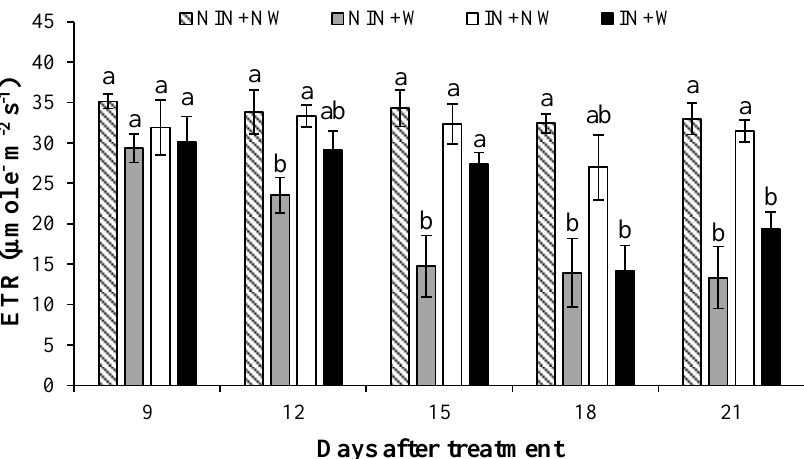
Figure 6. ETR in R. sativus under waterlogged conditions and inoculated with A. brasilense. Averages followed by different letters at each sampling point show statistical differences according to Tukey’s test ( p < 0.05). Vertical bars in each average indicate standard error ( n = 11).